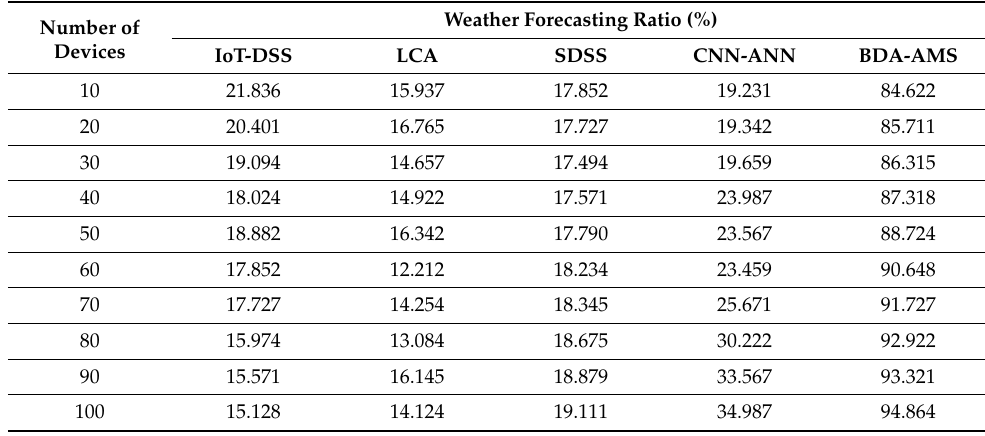
Table 2. Weather forecasting ratio